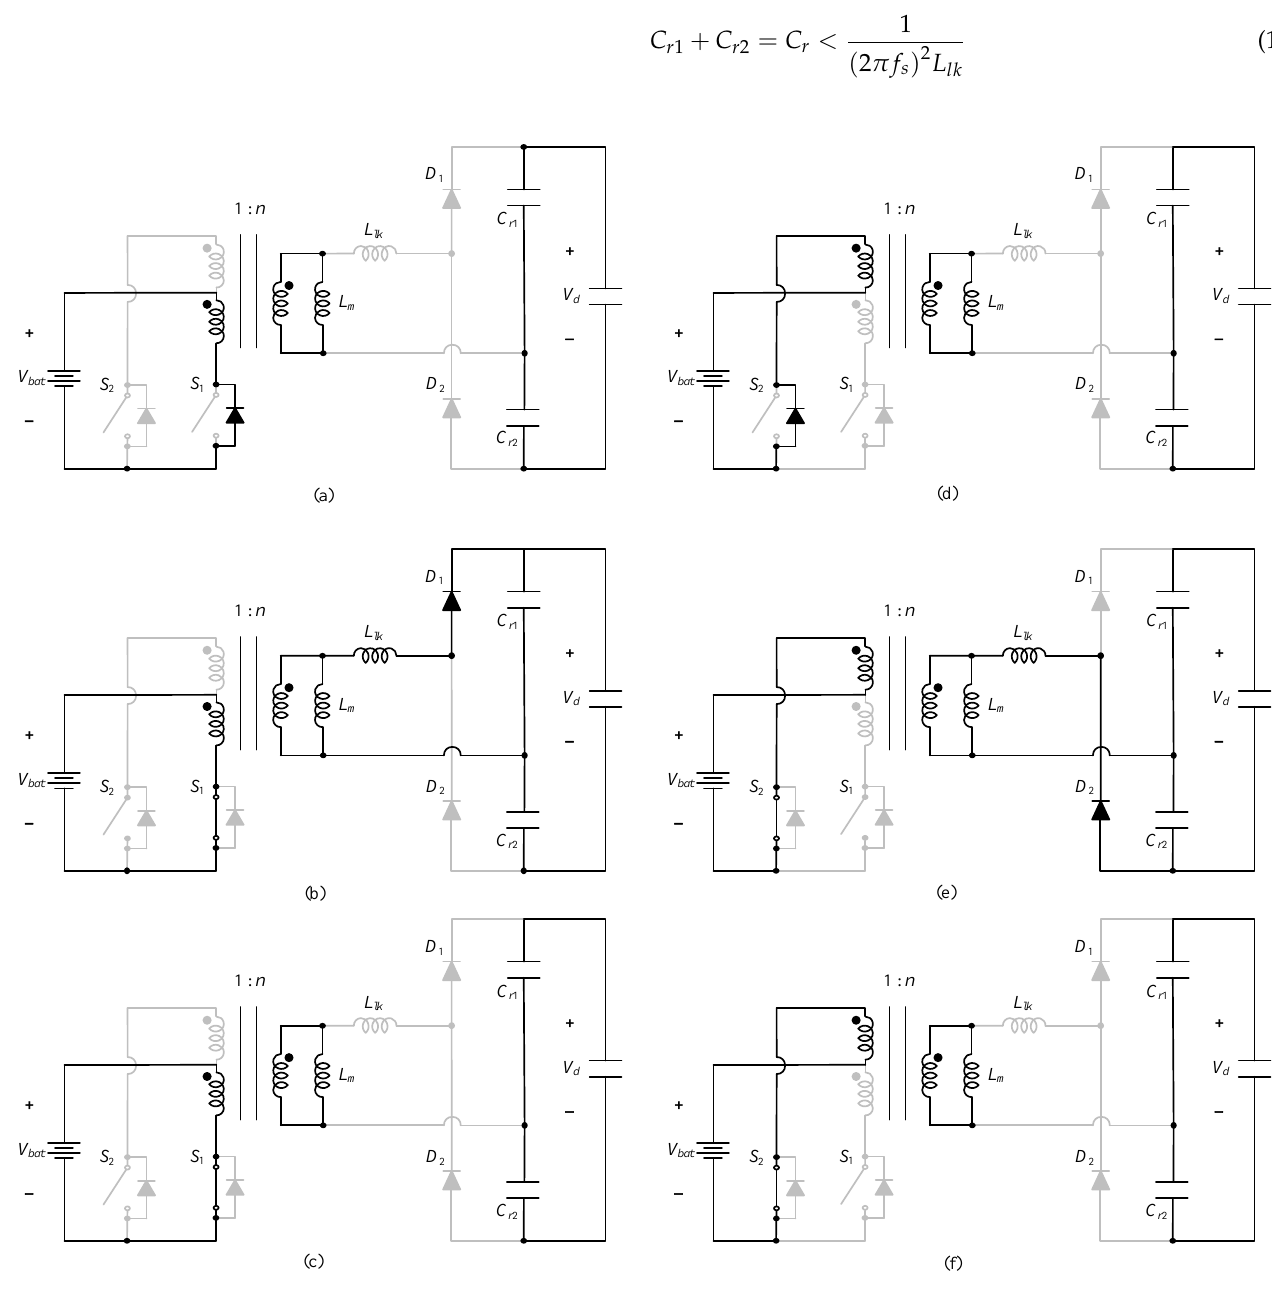
Figure 3. Operation modes: ( a ) Mode 1 ; ( b ) Mode 2 ; ( c ) Mode 3 ; ( d ) Mode 4 ; ( e ) Mode 5 ; and ( f ) Mode 6 . In order to reduce the size and the cost of the converter, a high frequency transformer was used in the proposed converter. Figure 5 shows the winding structure of the proposed transformer. The transformer was separately coiled around the primary and secondary windings utilizing a double E core. This method can be used to integrate a resonant inductor and the transformer. The leakage inductance of the transformer constituted the resonant inductor. It was possible to remove the passive component and resonant inductor. Based on the proposed method, the high frequency transformer of the converter was